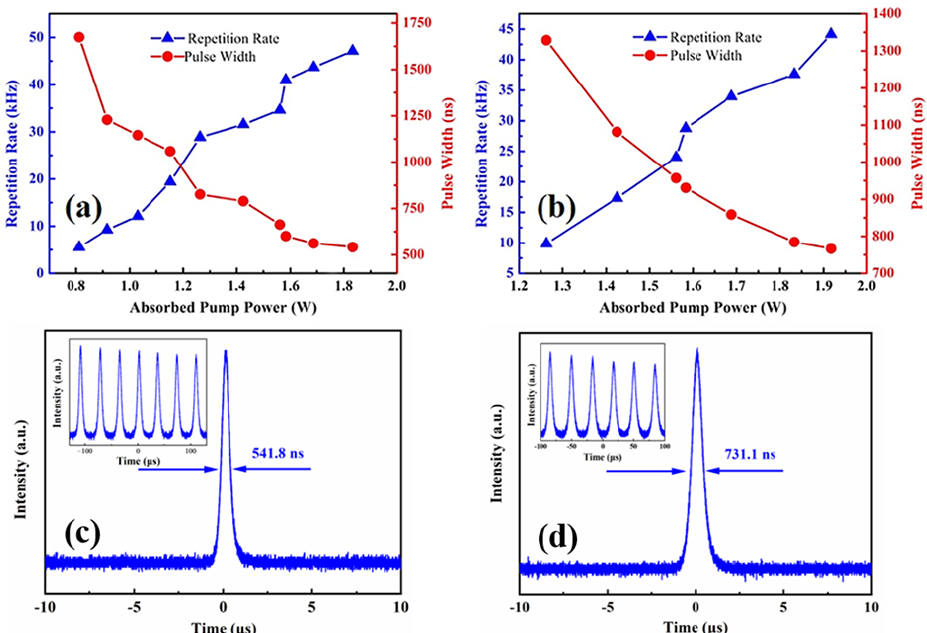
Figure 11. Absorption pump power versus repetition frequency and pulse width: ( a ) output coupler transmittance of 1%; ( b ) output coupler transmittance of 3%; ( c ) single pulse and pulse train with the output coupler transmittance of 1%; and ( d ) single pulse and pulse train with the output coupler transmittance of 3%.